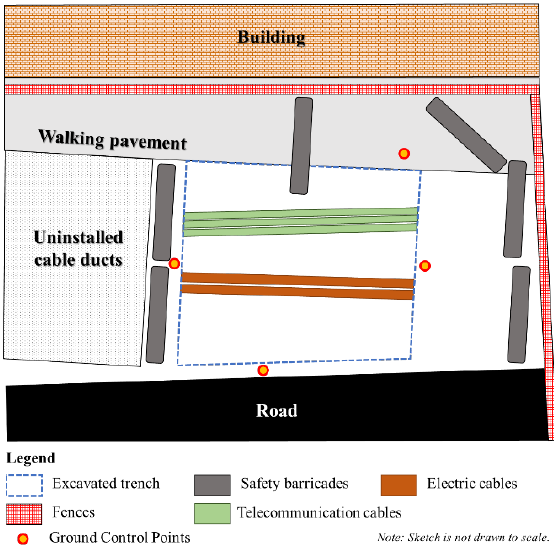
Figure 1 . Site sketch of excavated trench and